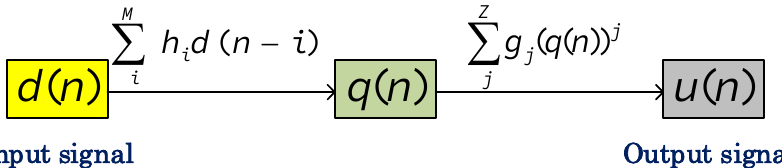
Figure 4. The input – output relationship of the Wiener model that describes the nonlinear response of an optical transmission system.